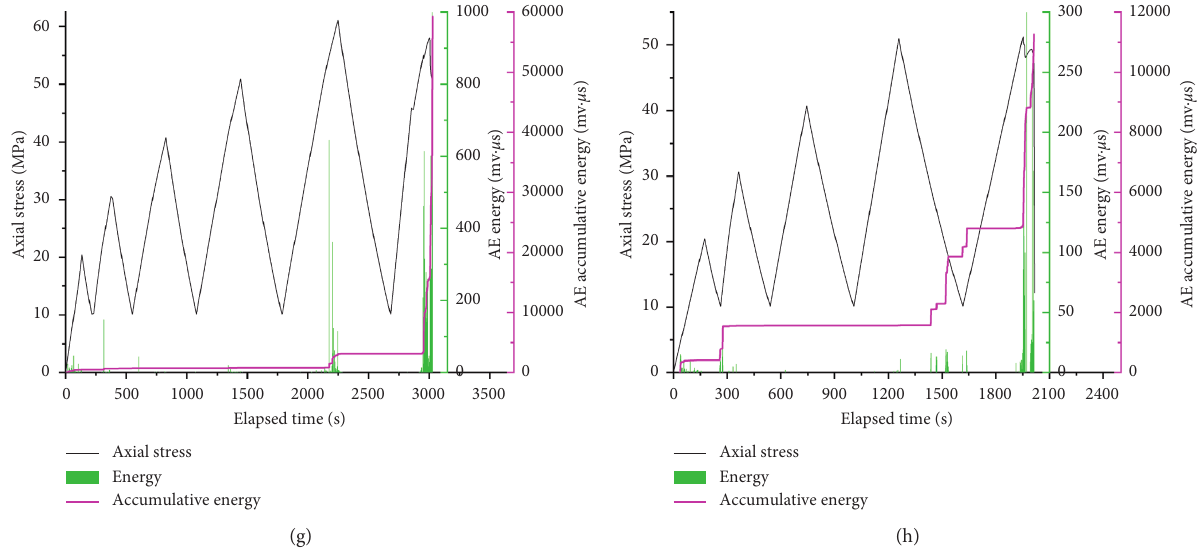
Figure 11: The AE energy statistics of rock samples subjected to different stress paths: (a) NF1; (b) FT1-3; (c) NF2; (d) FT2; (e) NF3; (f) FT3; (g) NF4; (h)